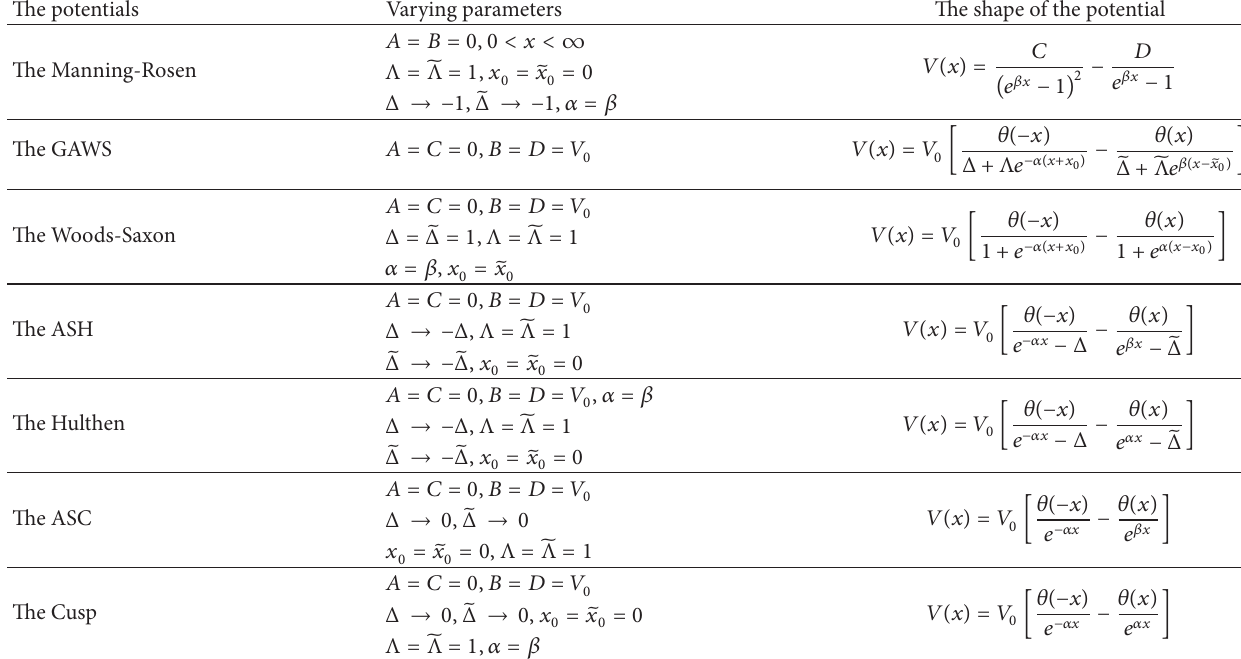
Table 1: The special potentials which are derived from the GAMAR type